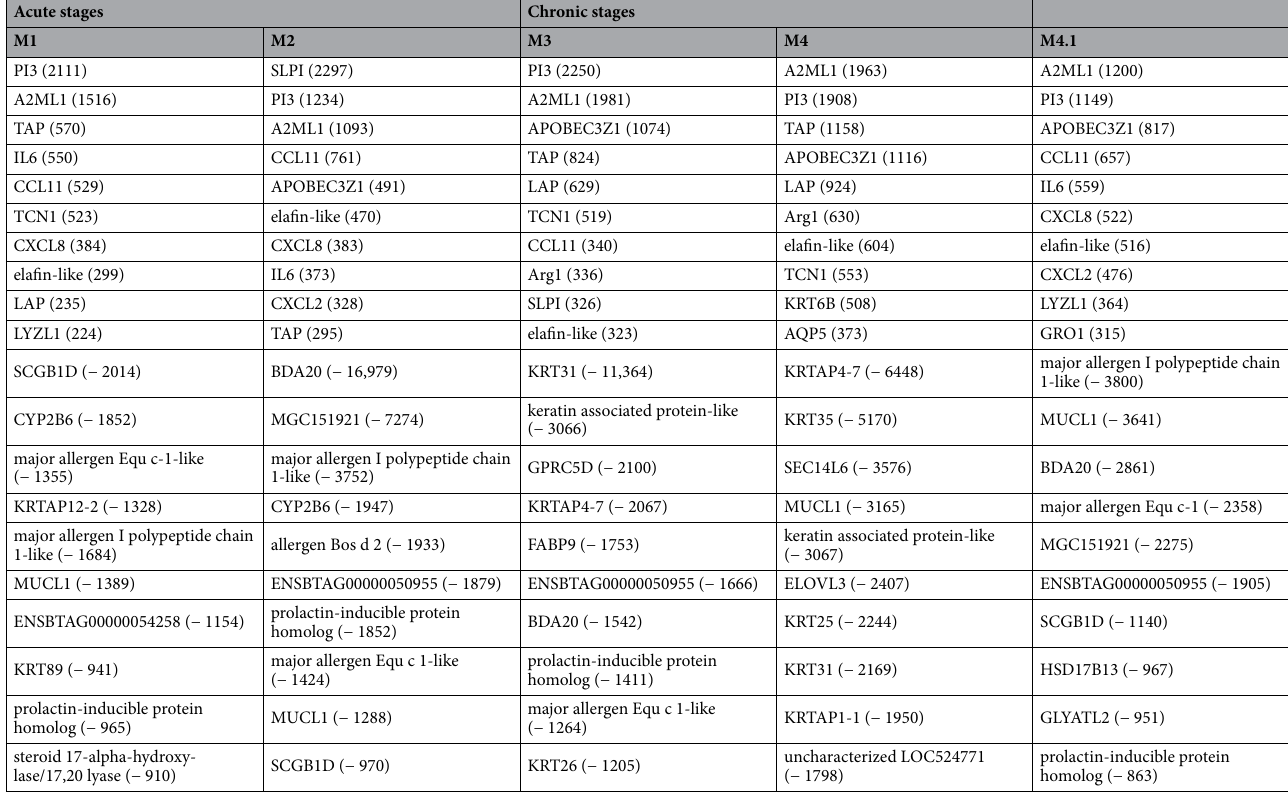
Table 3. The 10 most up- and downregulated differentially expressed genes in samples of M1, M2, M3, M4 and M4.1 lesions in comparison to healthy skin tissue. The fold change is shown between brackets behind the gene designation (adjusted p-value < 0.05). Unknown proteins are noted with their Ensembl identity. The fold change threshold is set at ≥ 2 for upregulated genes and ≤ -2 for downregulated